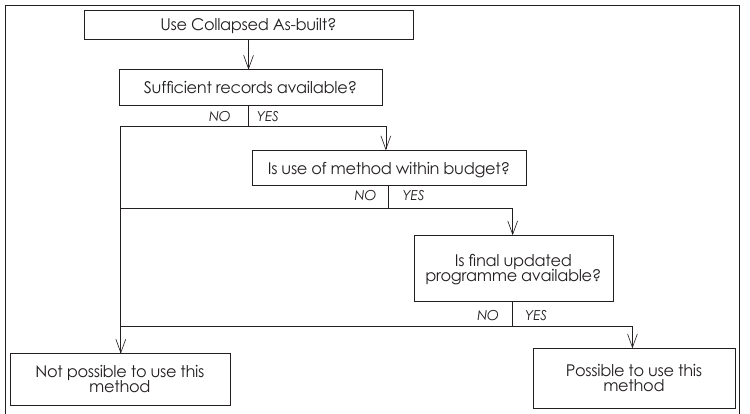
Use Collapsed As-built?